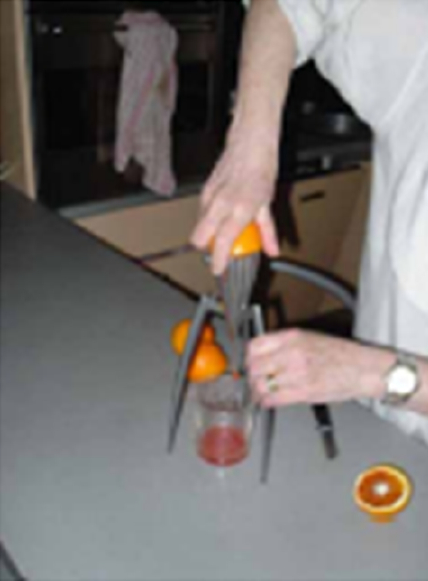
Fig. 2. Using JS on the kitchen